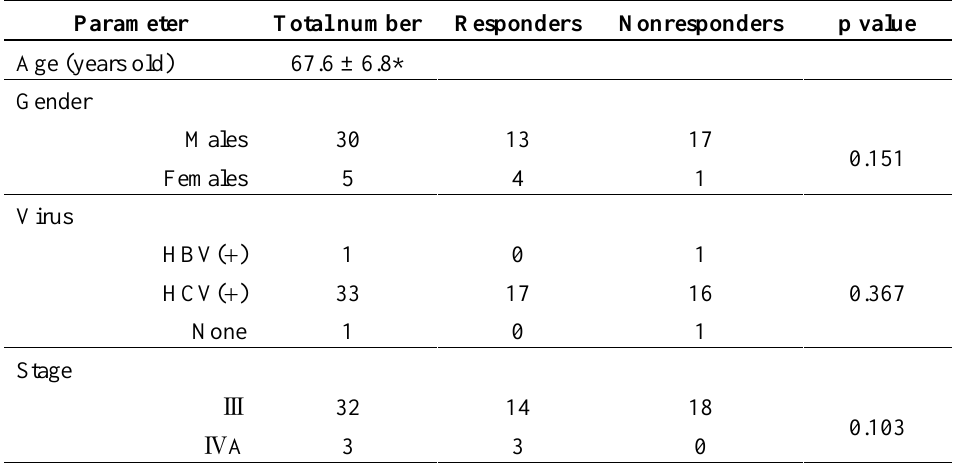
Table 1. Patient characteristics and clinical